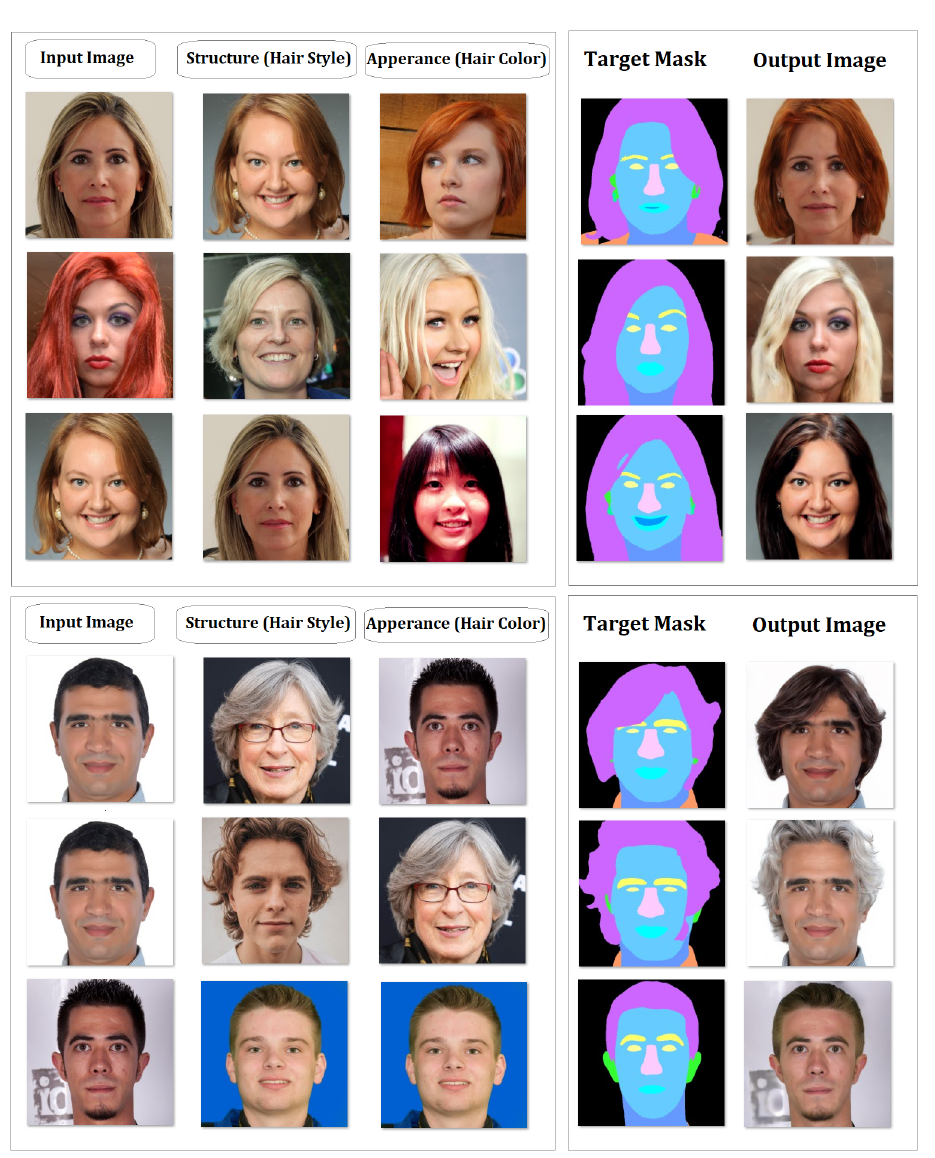
Figure 3. Hairstyle transfer is accomplished by transferring appearance features and structural details from input